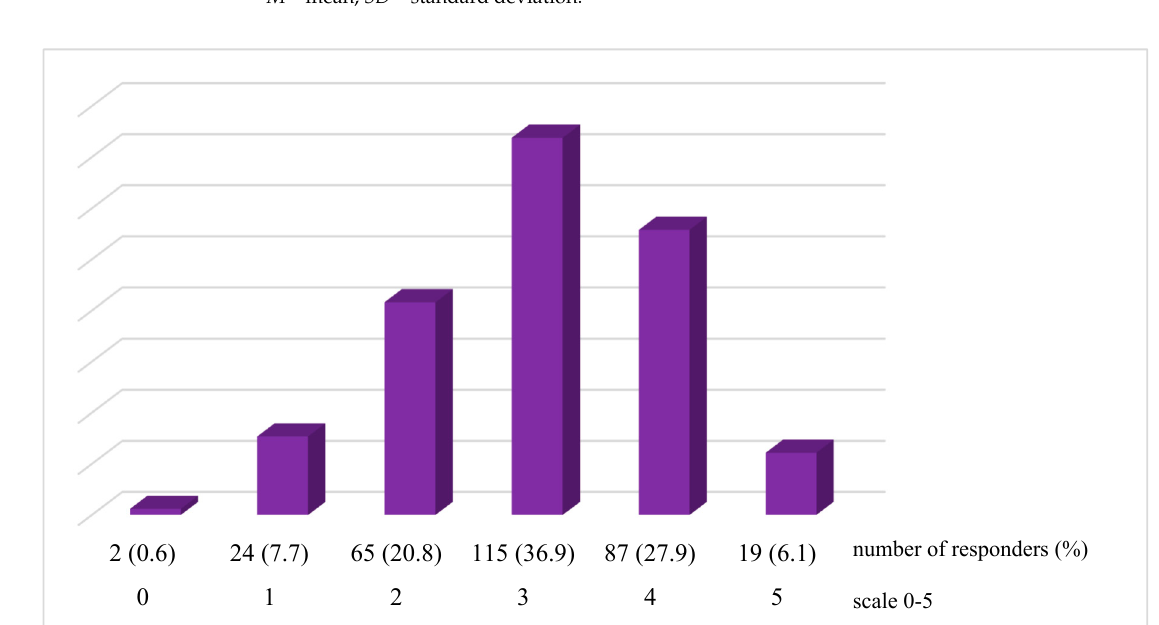
Figure 1. Stress level among the responders ( n = 312).